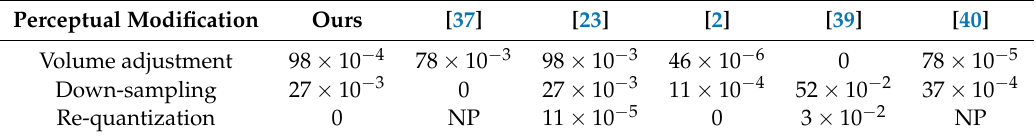
Table 8. Comparison with state-of-the art